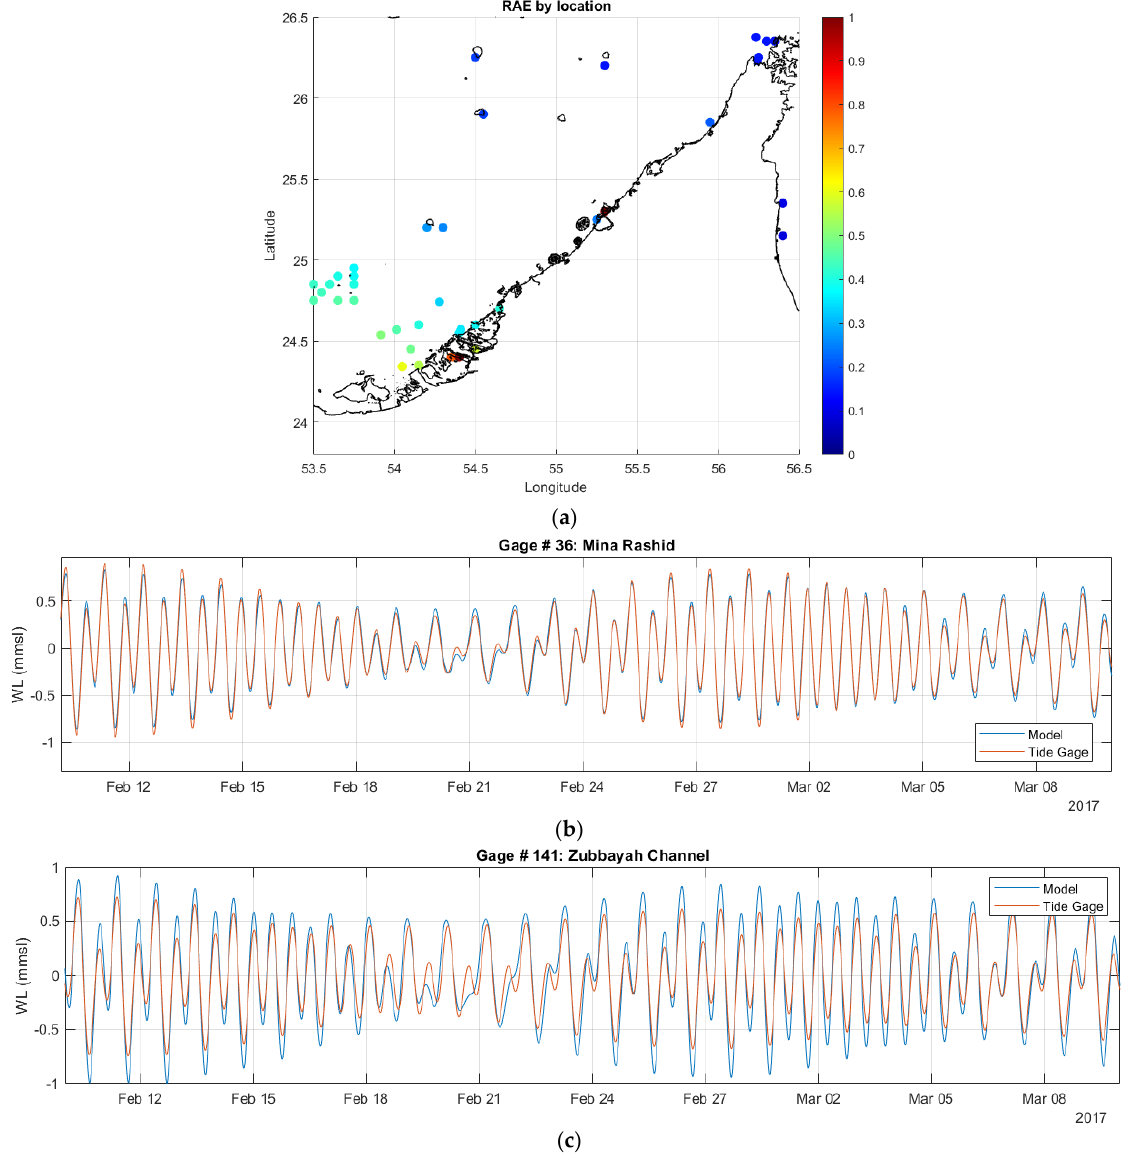
Figure 4. Comparison of model output and TPXO8 tidal atlas values: ( a ) RAE computed using Equation (1) and plotted for each tidal gauge location located near the UAE coastline ( b ) Comparison of model output and TPXO8 tidal atlas water level time series from 10 February to 10 March 2017 at Mina Rashid, with RMS error of 0.246 ( c ) Comparison of model output and TPXO8 tidal atlas water level time series for 10 February to 10 March 2017 at Zubbayah Channel, with RMS of 0.484.